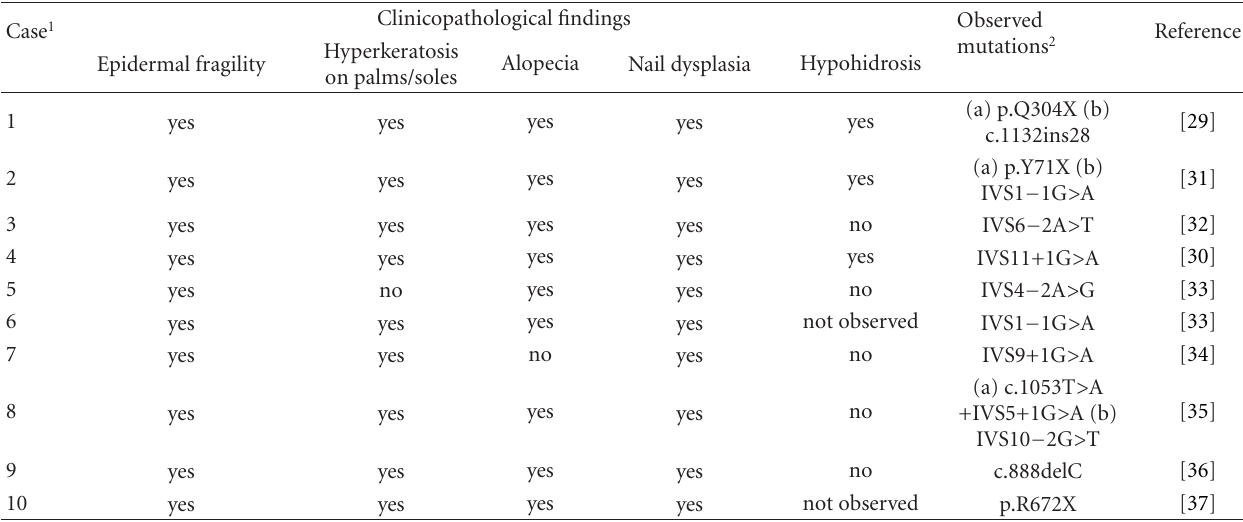
Table 1: Published cases of EDSF syndrome with clinical features and observed mutations in PKP 1